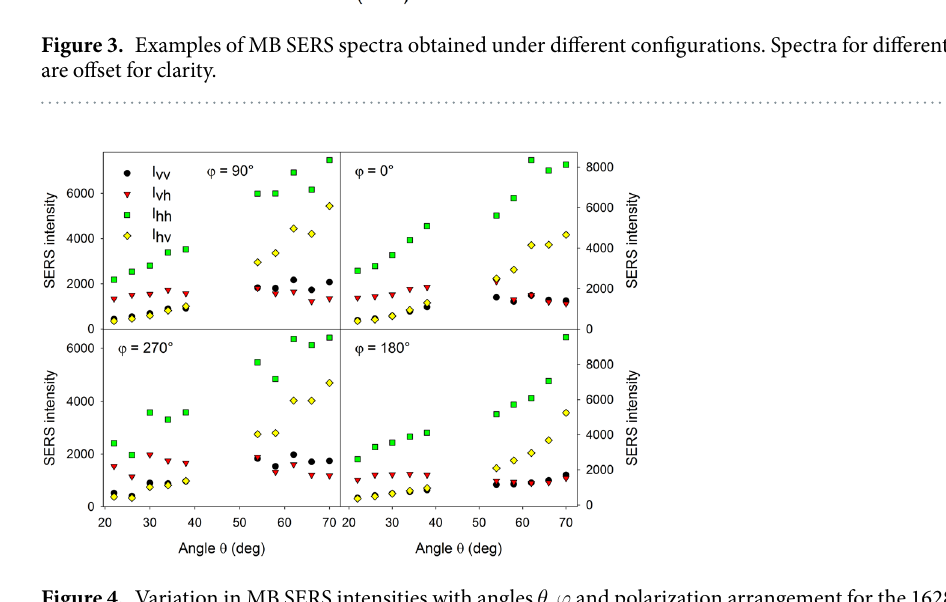
Figure 4. Variation in MB SERS intensities with angles θ , ϕ and polarization arrangement for the 1628-cm − 1